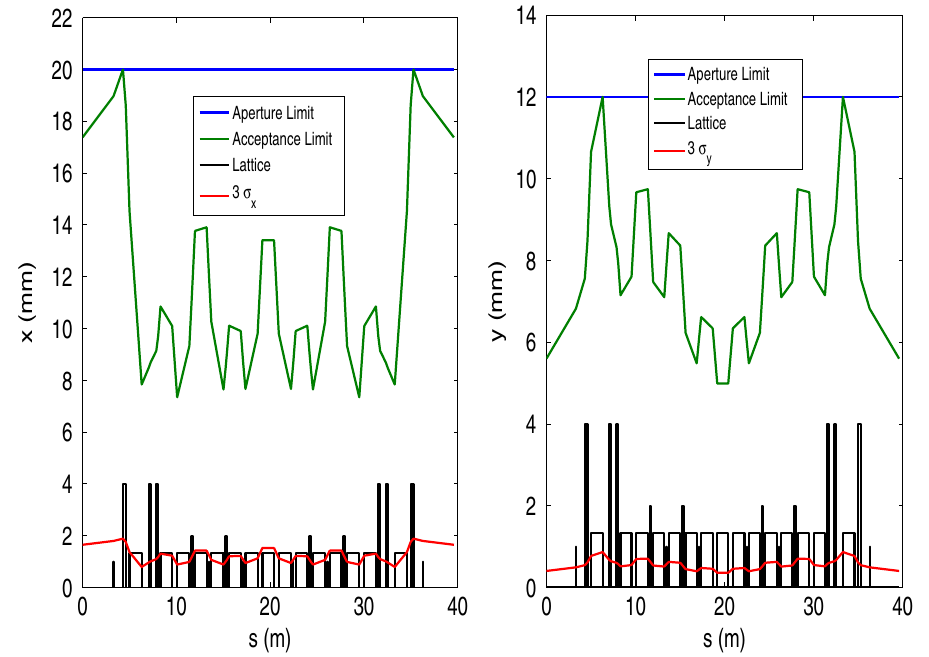
FIG. 3. The horizontal (left) and vertical (right) aperture limit in the NSLS-II booster.